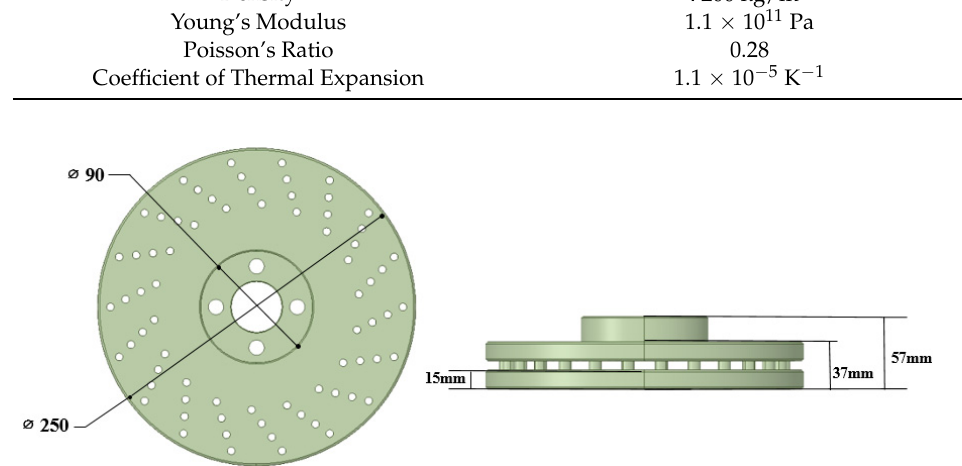
Figure 3. Disc model specifications.